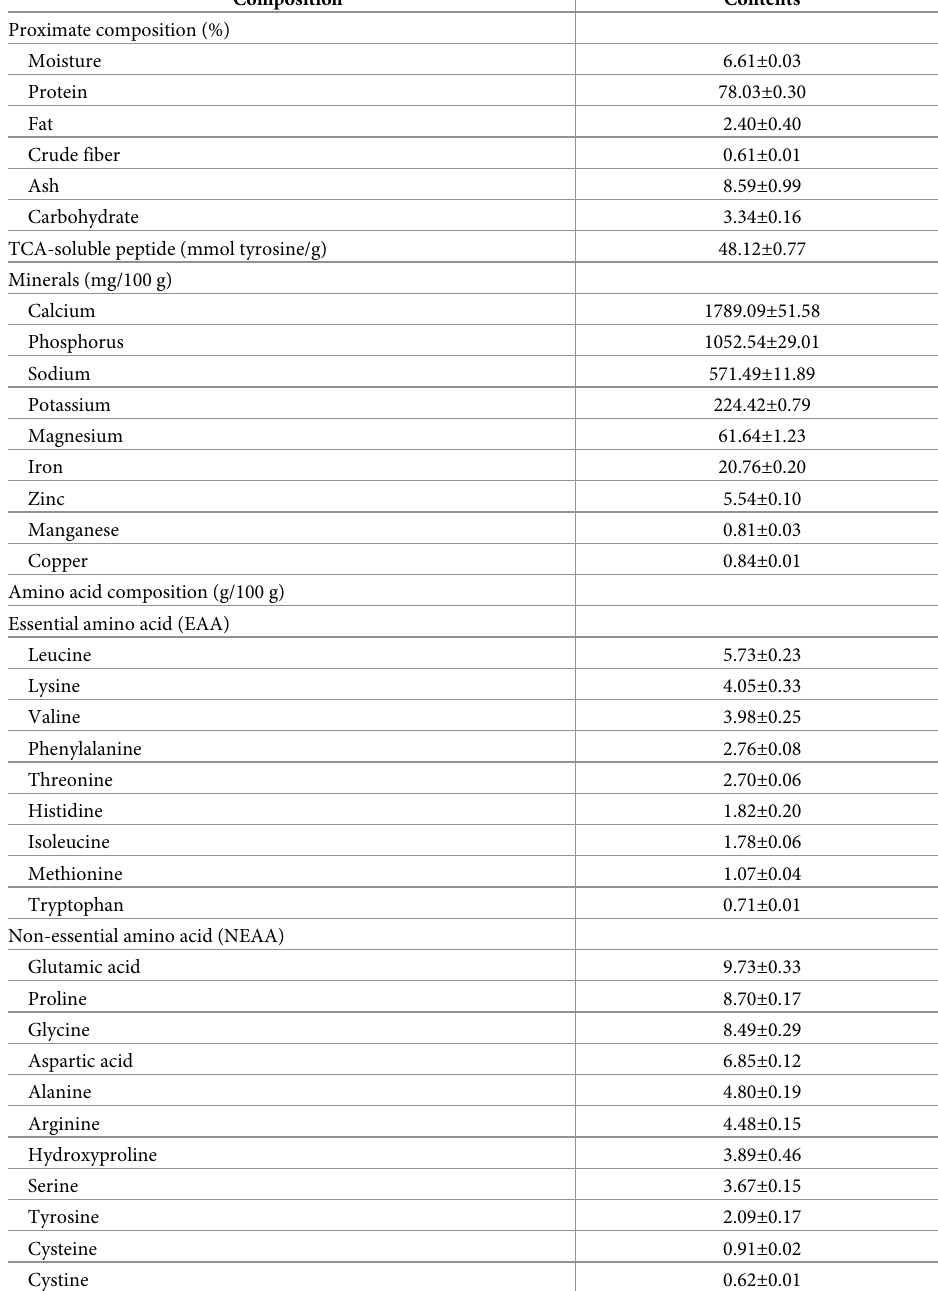
Table 1. Proximate composition, TCA-soluble peptide, mineral profile, and amino acid composition of freeze- dried porcine